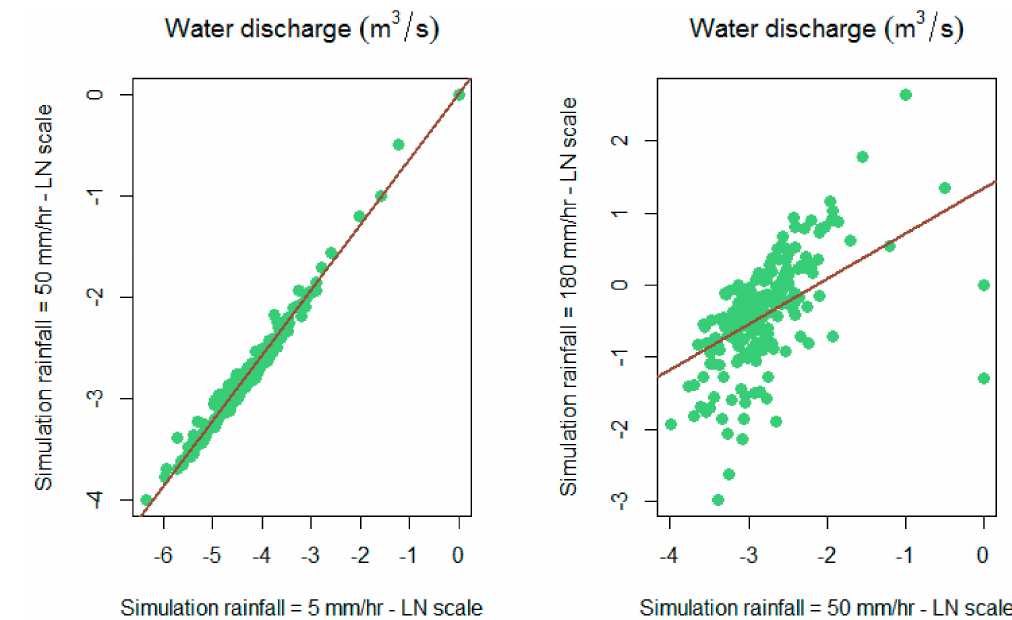
Figure 12. Relation between water discharge values for different precipitation intensities.